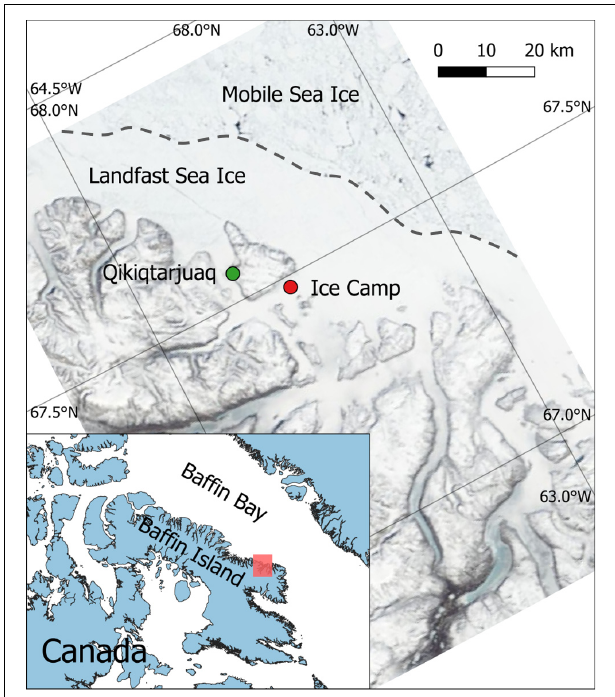
FIGURE 1 | Location of the ice camp as part of the GreenEdge campaign in 2016 on landfast sea ice near Qikiqtarjuaq, Southern Baffin Island, NU, Canada (MODIS image, 13 June